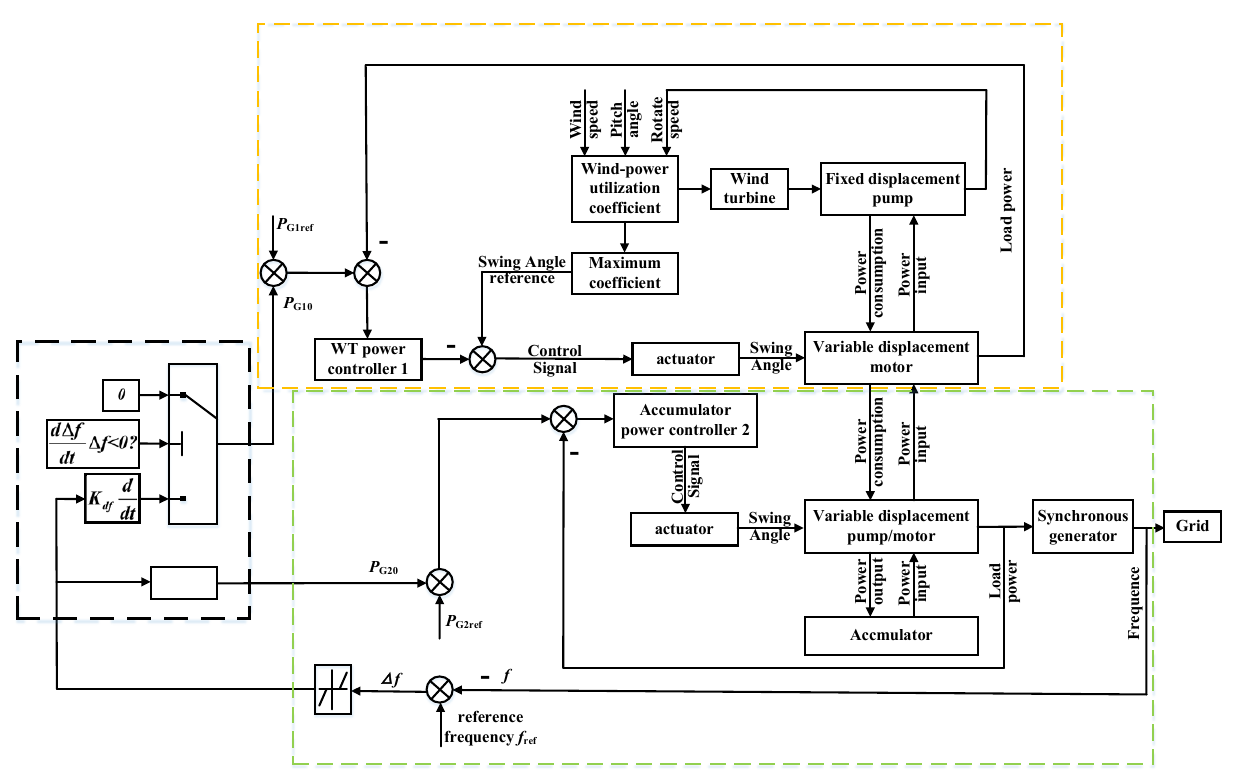
Figure 8. The idea of wind turbine and energy storage frequency modulation control.